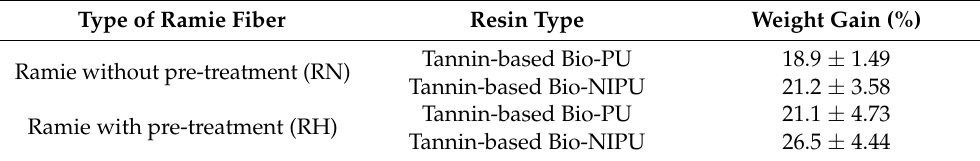
Table 2. Weight gain of untreated and pre-treated ramie fiber impregnated with different resin types. Type of Ramie